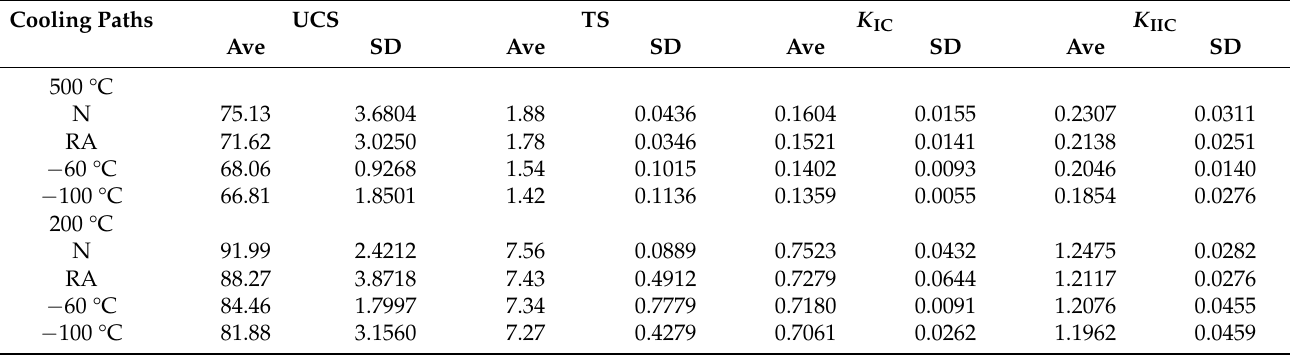
Table 3. Mechanical test results of granite specimens after thermal